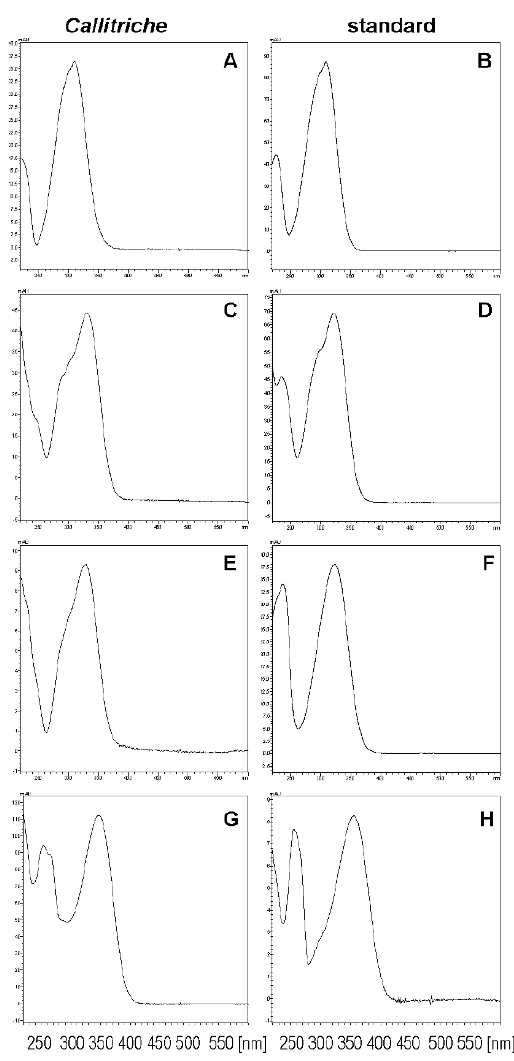
Figure 2. Comparison between the representative absorption spectra of the identified fractions of Callitriche freeze- dried material and standards. A, B – p- coumaric acid; C, D – ferulic acid; E, F – sinapic acid; G, H – quercetin rutinoside.